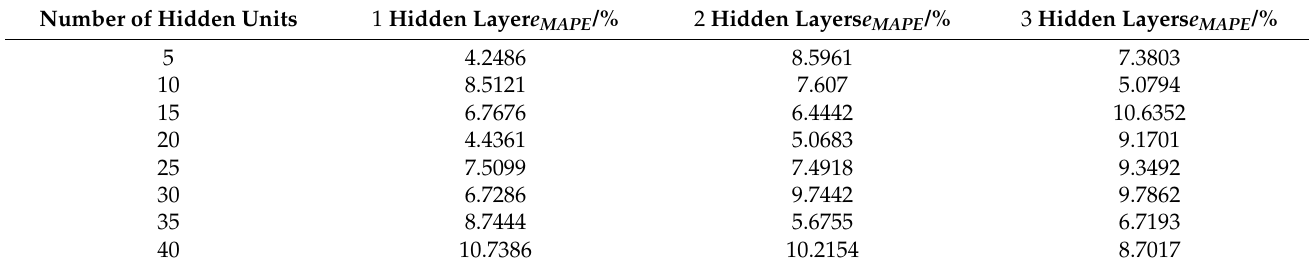
Table 3. Forecasting performance of different LSTM network